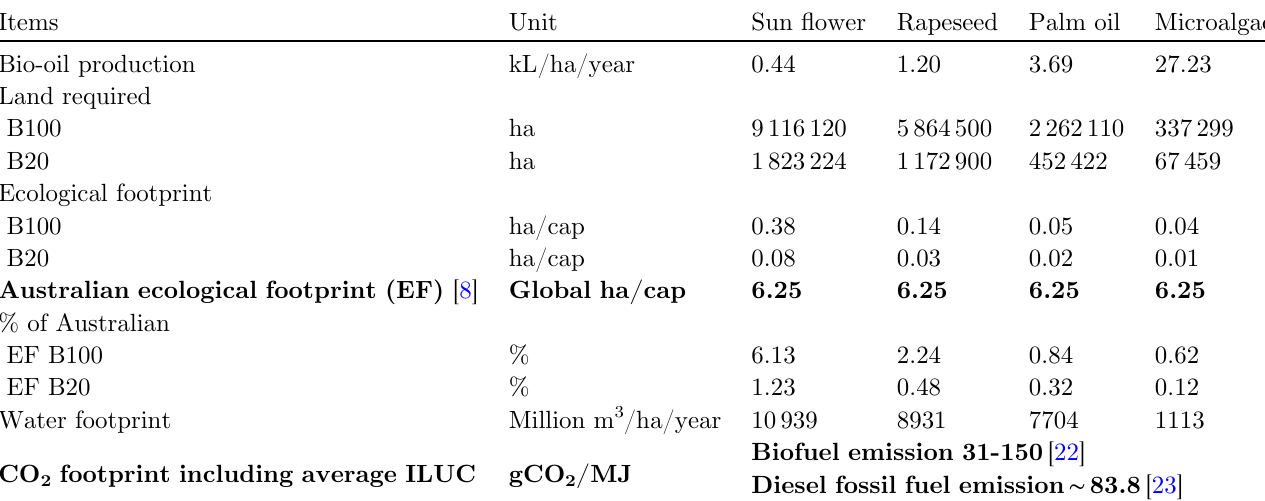
Table 1. Research fi ndings on ecological footprint from selected biofuel crops in Australia.